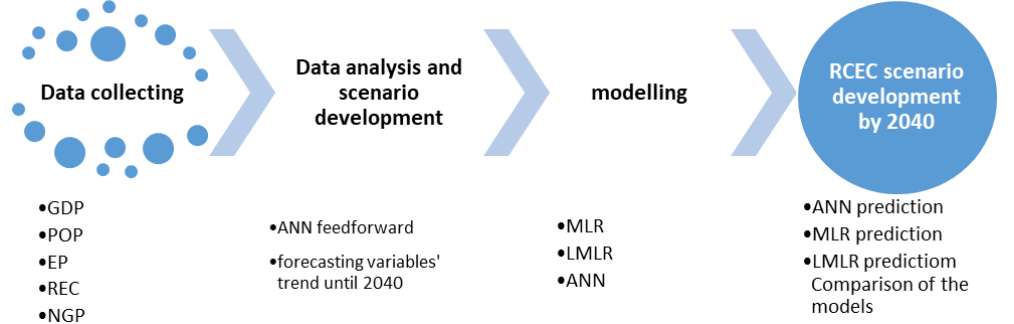
Figure 9. Model development